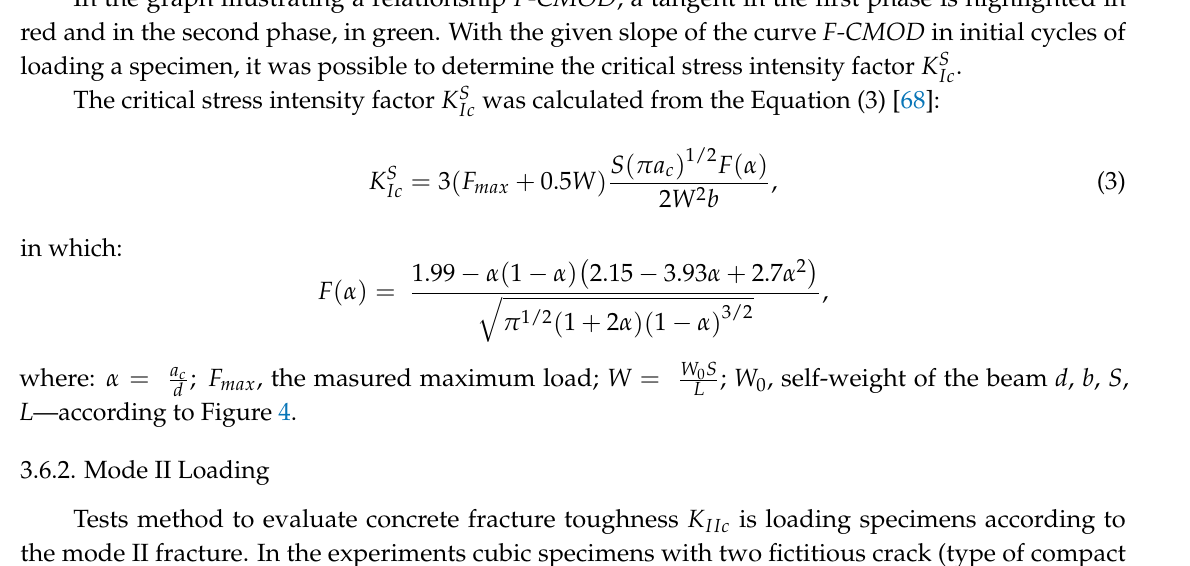
Figure 7. View of experimental stand for testing according to mode II fracture: ( a ) specimen during testing, ( b ) specimen with dimensions and loading conditions; 1—specimen, 2—stiff plate, 3—MTS 810 press, 4—initial crack (dimensions in mm).